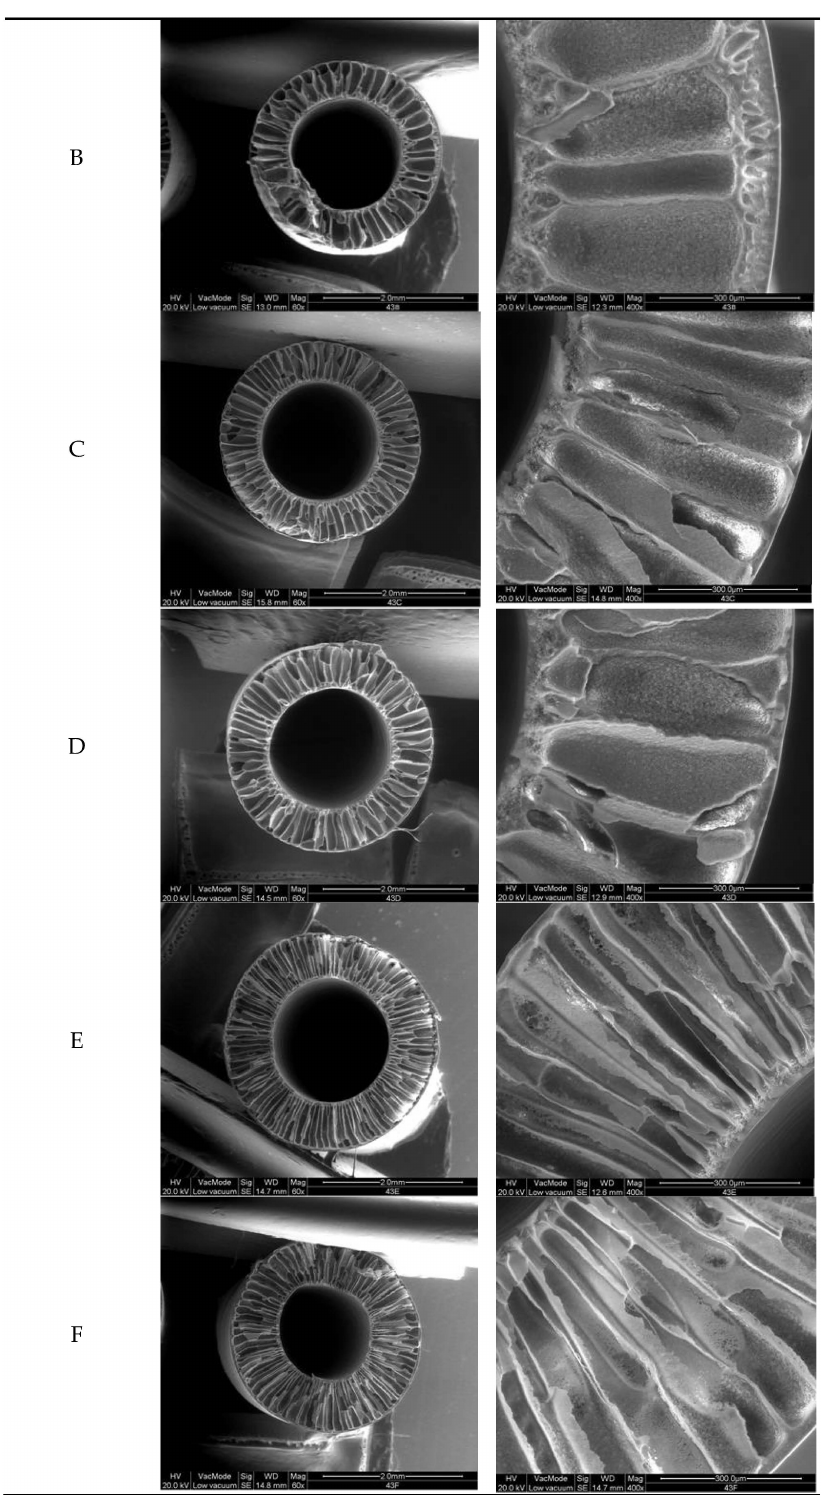
Figure 1. SEM pictures of the PVDF hollow fibers produced using the indicated bore fluid composition and flow-rate: A) DMF 45%, 9 mL/min; B) DMF 45%, 12 mL/min; C) DMF 45%, 15 mL/min; D) DMF 45%, 18 mL/min; E) EtOH 45%, 18 mL/min; F: EtOH 45%, 15 mL/min. Lee et al. [33] investigated the trade-off between thermodynamic and kinetic factors, in polysulphone (PSU) membranes formation, using the additive PVP. They observed that, until